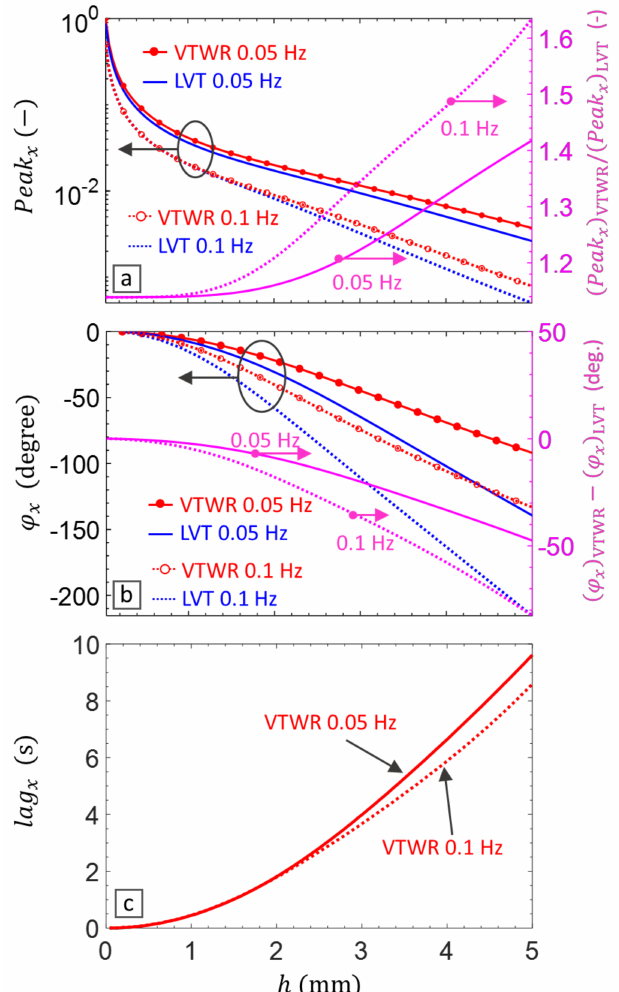
Figure 2. Simulation of VTWR using a 5 bit Barker coded waveform (see Figure 1a) at two AM frequencies 0.05 and 0.1 Hz for inspection of a 5 mm thick CFRP, and its comparison with 5 cycles LVT at the same AM frequency. ( a ) Peak χ , ( b ) ϕ χ , and ( c ) lag χ